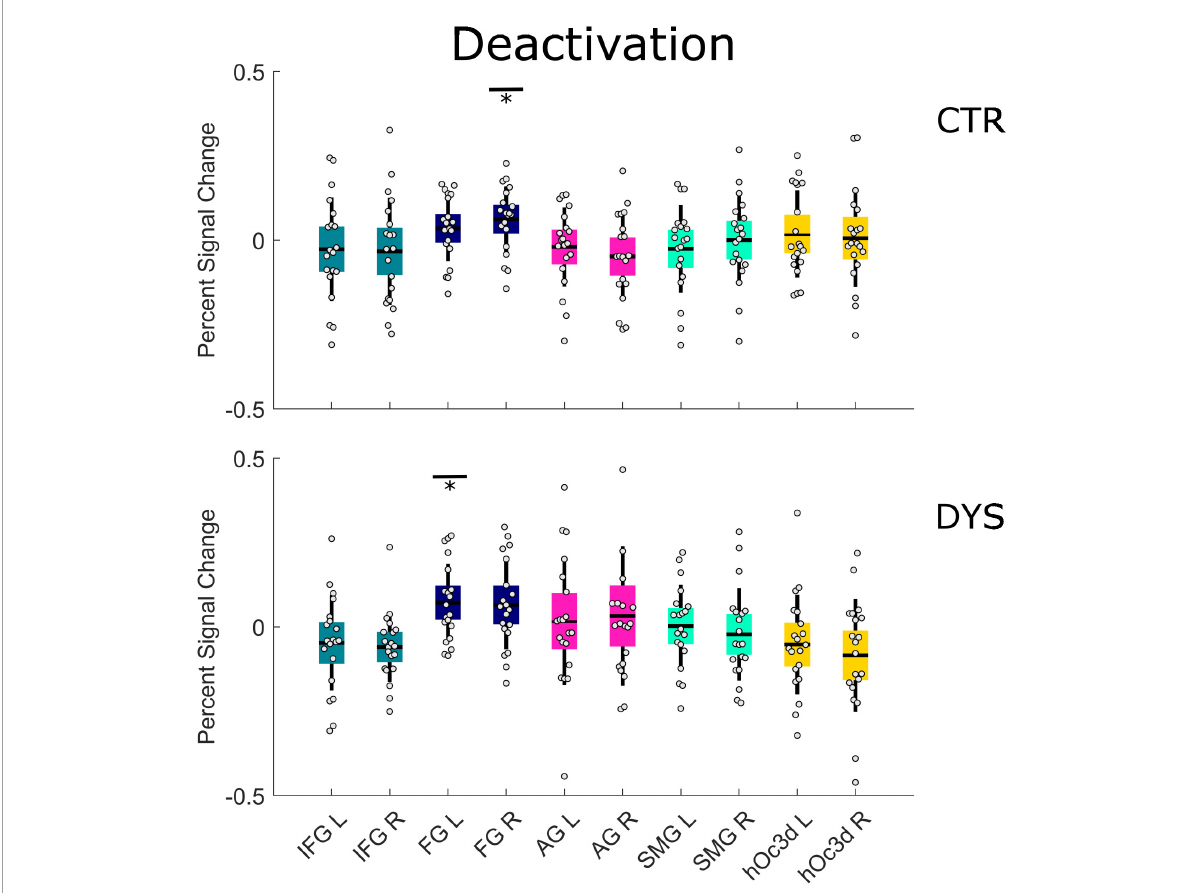
FIGURE7 Univariate ROI results of the deactivation repetition effect (regions that show a linear decrease in activation). Percent signal change is displayed for each group (DYS and CTR) and for each of the ten predefined ROIs. The asterisks indicate significant effects * p < 0.05 after correcting for multiple comparisons using FDR. DYS: dyslexic readers, CTR: typical readers, IFG: inferior frontal gyrus, FG: fusiform gyrus, AG: angular gyrus, SMG: supramarginal gyrus, hOc3d: Dorsal extrastriate cortex, L: left hemisphere, R: right